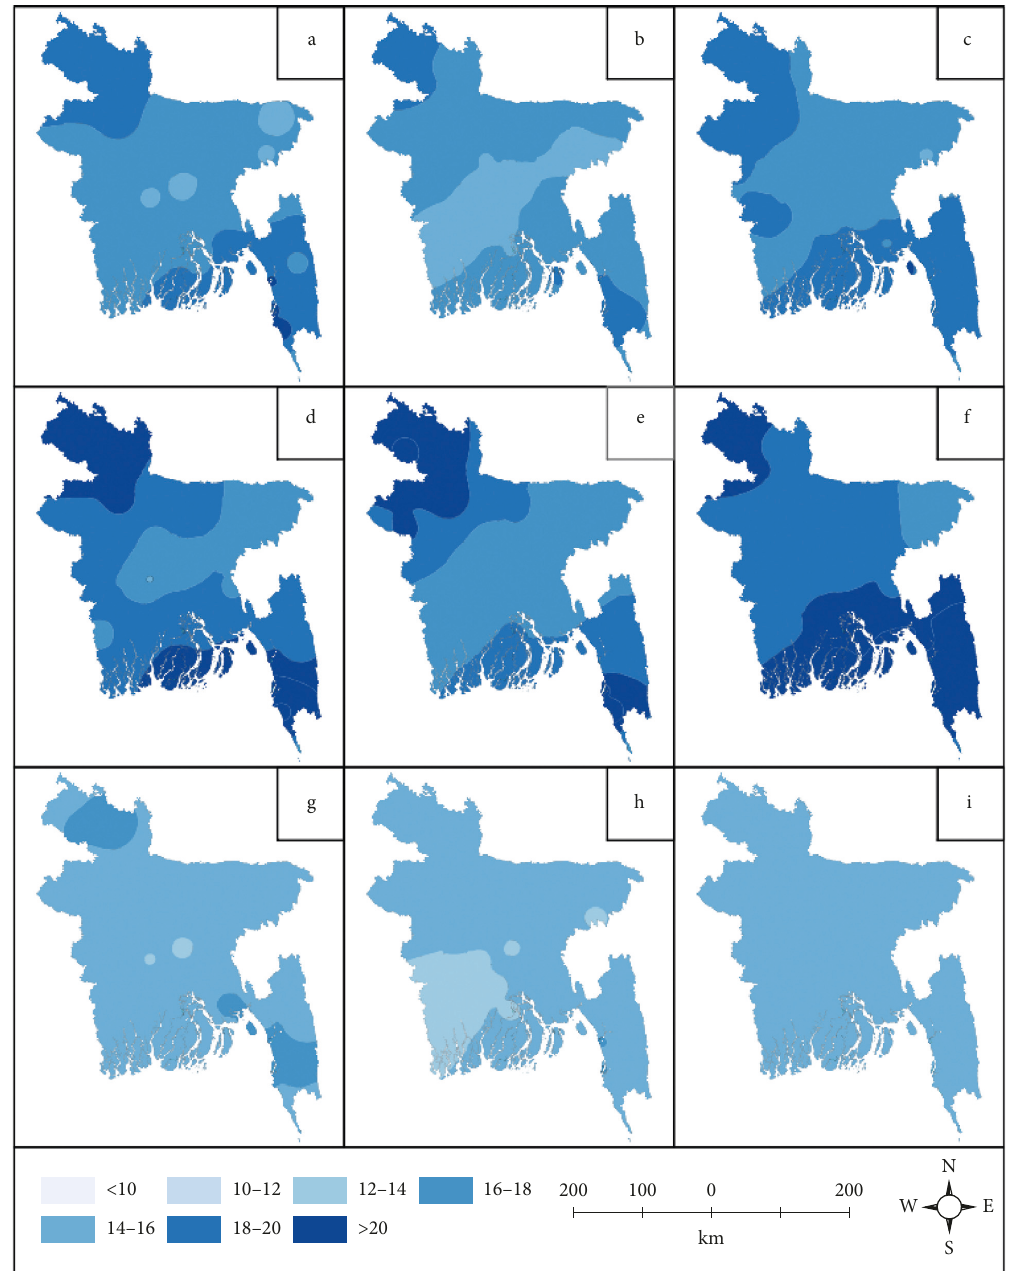
Figure 5: Decadal analysis of annual PCI for (a) 1980–1989; (b) 1990–1990; (c) 1990–1990; (f) 2000–2011. Six-month PCI of JD for (g) 980–1989; (h) 1990–1990; (i)